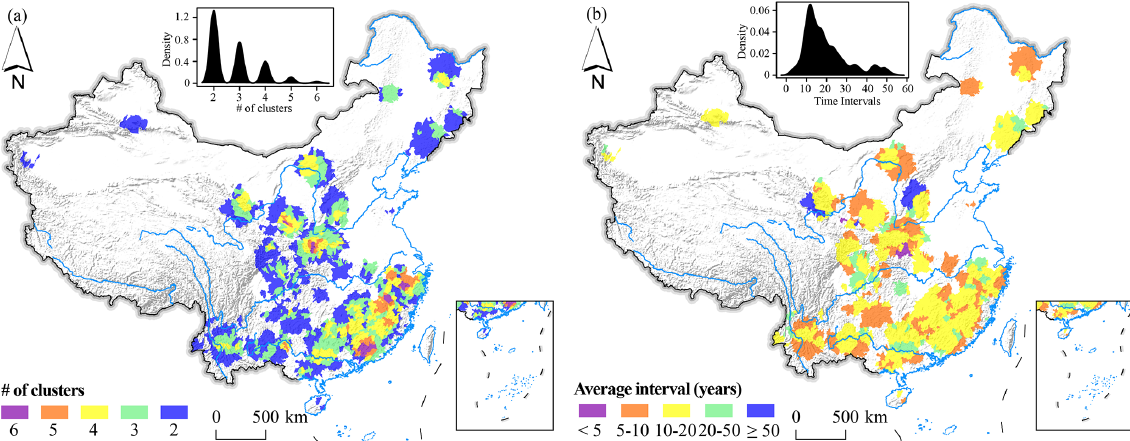
Figure 10. Number of times a cluster has been detected per catchment and by decade (a) . Average time interval between two clusters detected over the same catchment by decade (b)